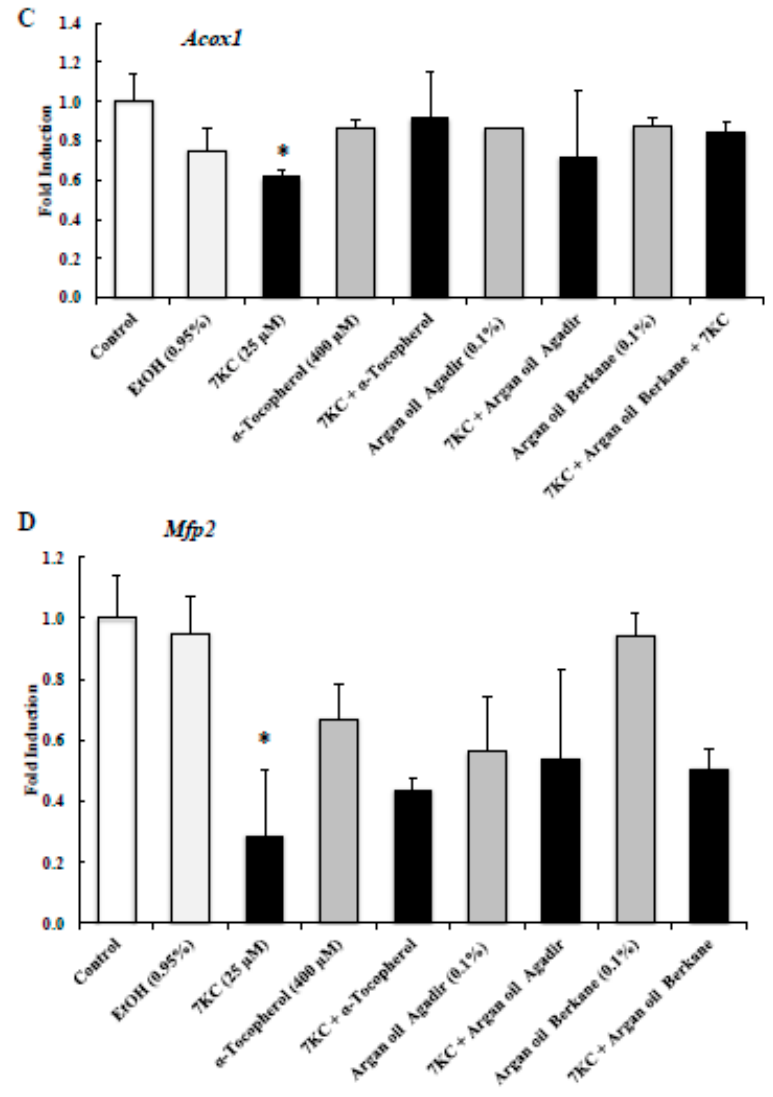
Figure 5. Effects of argan oil on 7-ketocholesterol-induced decreased transcription of Abcd1 , Acox1 , Mfp2 , and Abcd3 . After 24 h of culture, 158N murine oligodendrocytes were cultured for an additional 24 h without or with 7KC (25 µM) in the absence or presence of argan oils (Agadir or Berkane; Morocco; 0.1% v / v ) or of α -tocopherol (400 µM) used as the positive control. Argan oils and α - tocopherol were added to the culture medium 2 h before 7KC. The mRNAs of the peroxisomal transporters ( Abcd1 ) ( A ), and of the peroxisomal enzymes ( Acox1 , and Mfp2 ) ( C–D ) as well as of Abcd3 (a marker of the peroxisomal mass); ( B ) were quantified by RT-qPCR. To this end, 36B4 was used as the reference gene. Data are mean ± SD of two independent experiments carried out in triplicate. The significance of the relationship between vehicle and cells treated with 7KC, argan oils or α -tocopherol was calculated by the Anova test (Sidak’s multiple comparisons); * p ≤ 0.05. The significance of the relationship between cells treated with 7KC alone, 7KC and argan oils cotreatment, or 7KC and α -tocopherol cotreatment was calculated by the Anova test (Sidak’s multiple comparisons); # p ≤ 0.05. No significant difference was found between control and vehicle-treated cells (EtOH 0.95% v / v